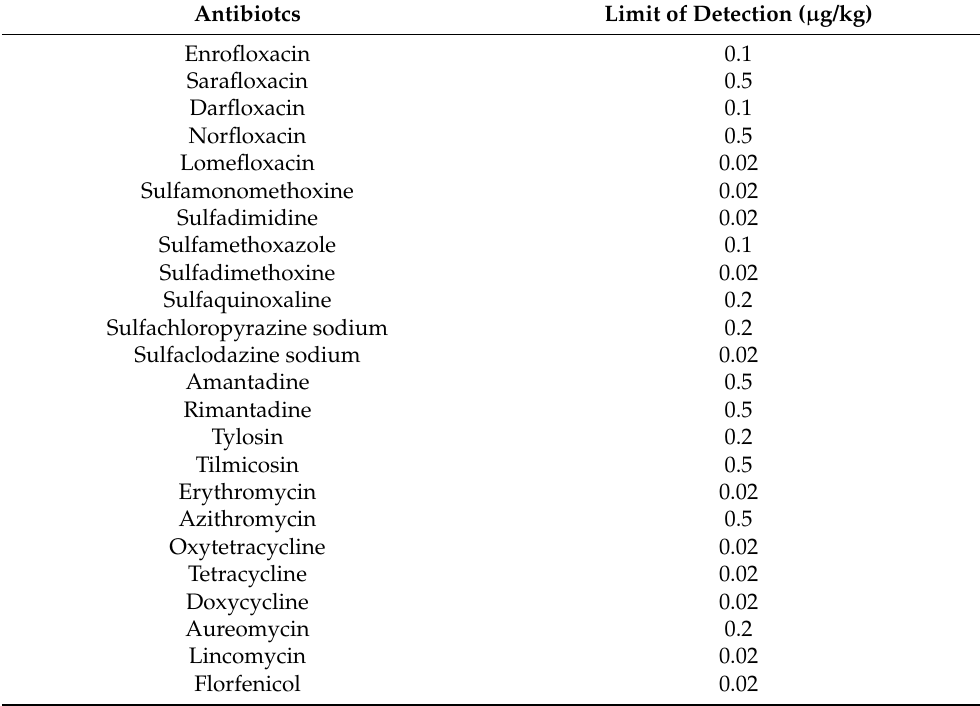
Table 1. Limit of detection (LOD) of 24